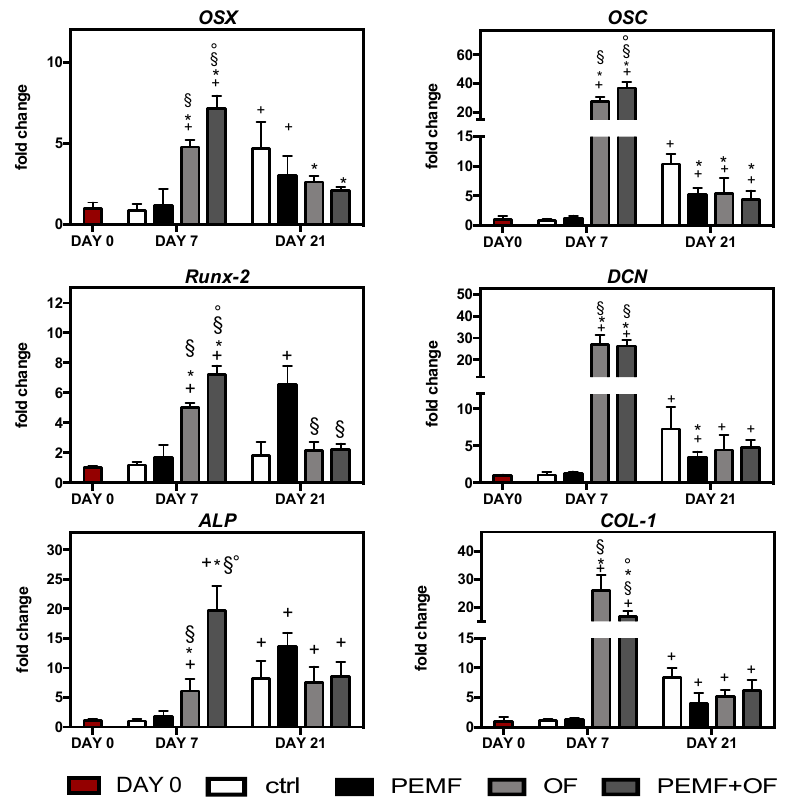
Figure 4. Gene expression of bone-specific markers as determined by quantitative reverse-transcription polymerase chain reaction (qRT-PCR) at day 7 and 21 of culture. Graphs show the fold change of gene expression relative to the expression in the cells at day 0. Symbols indicate statistical significance vs. day 0 ( + ), vs. control (*), vs. PEMF (§) and vs. OF ( ◦ ) as determined by two-way ANOVA (N = 2, n = 3). Abbreviations: OSX , osterix; Runx -2, runt-related transcription factor-2; ALP , alkaline phosphatase; OSC , osteocalcin; DCN , decorin; COL-I, type-I collagen.